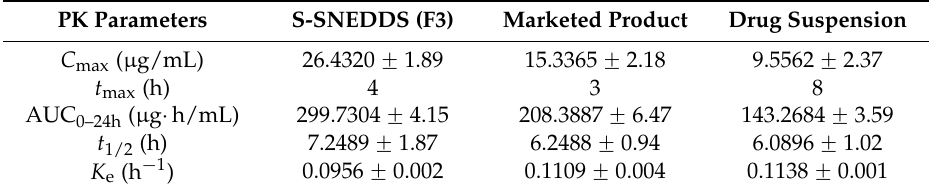
Table 11. Pharmacokinetic Parameters of OLM After Oral Administration of Optimized S-SNEDDS Formula (F3), Marketed Product and Pure Drug in